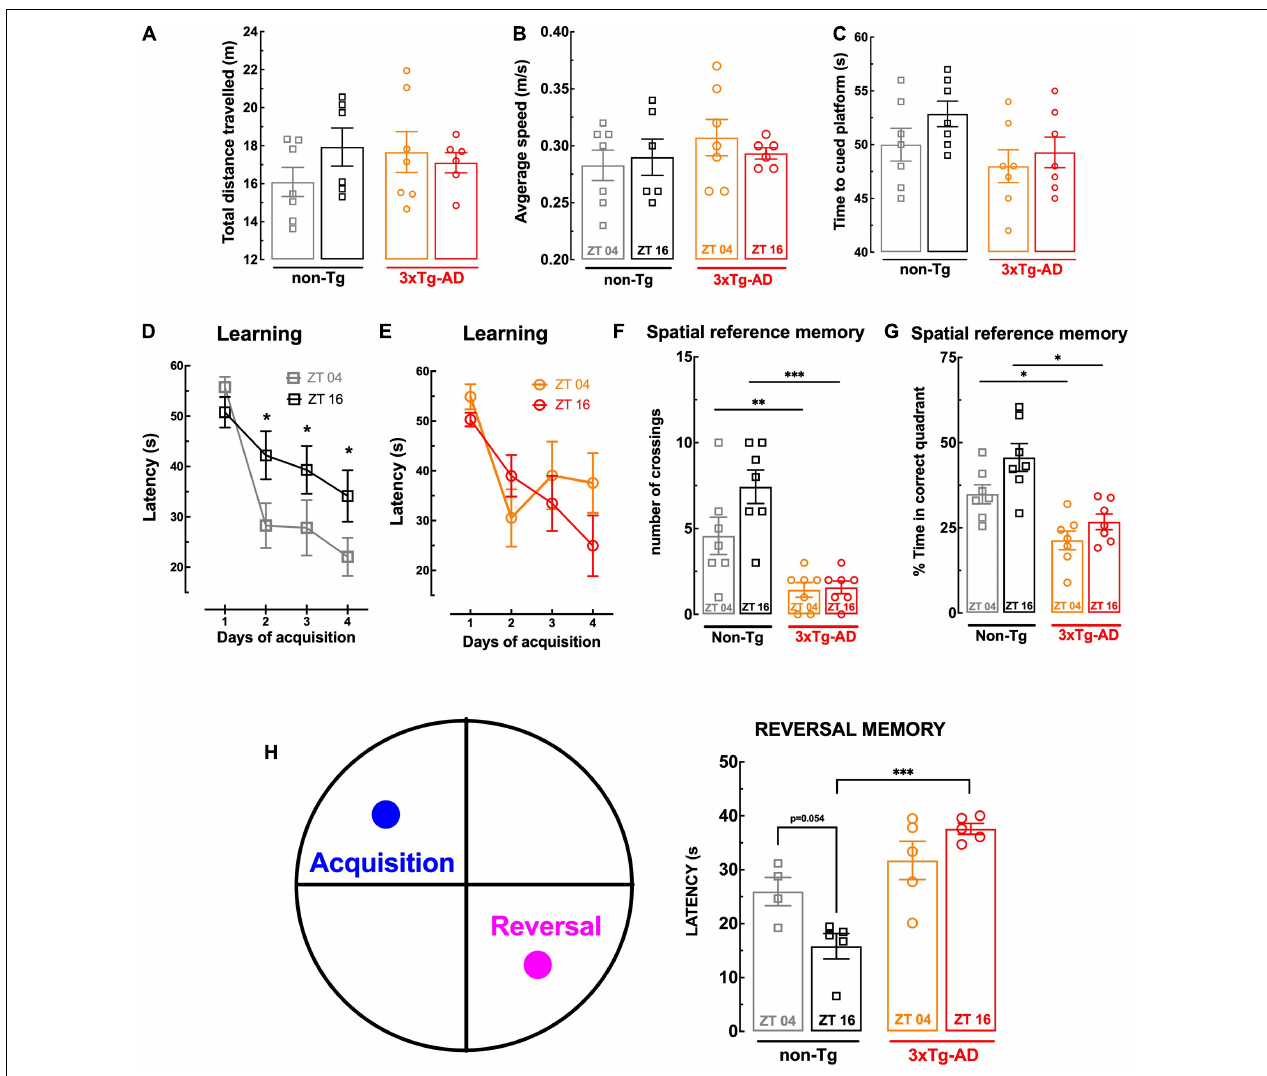
FIGURE 1 | Behavior comparison of non-Tg and 3xTg-AD mice at ZT04 (inactive phase) and ZT16 (active phase). There was no effect of genotype or circadian period on swimming activity, assessed as the total distance traveled (A) and of the average speed (B) in the Morris water maze (MWM), or visual capabilities, assessed as the latency to reach the visibly tagged platform in the MWM (C) . The 3xTg-AD mice presented a poor learning performance in the MWM than non-Tg mice at ZT04 but not at ZT16 (D,E) , and there was a circadian variation of learning in non-Tg, which was not present in 3xTg-AD (D,E) . Spatial reference memory assessed in the MWM was poorer in 3xTg-AD than non-Tg mice at both times of the day without circadian variations (F,G) , whereas reversal memory in the MWM displayed a circadian variation in non-Tg mice, which was not present in 3xTg-AD mice, which displayed a poorer performance at ZT16 but not at ZT04 (H) . Data are mean ± SEM of 4–7 mice per group, as indicated by the individual symbols (non-Tg at ZT04 in gray squares, non-Tg at ZT16 in black squares, 3xTg-AD at ZT04 in orange circles, and 3xTg-AD at ZT16 in red circles). Statistical analysis: ∗ p < 0.05, ∗∗ p < 0.01; ∗∗∗ p < 0.001 vs. other ZT or between indicated bars using a Newman–Keuls post hoc test after a two-way